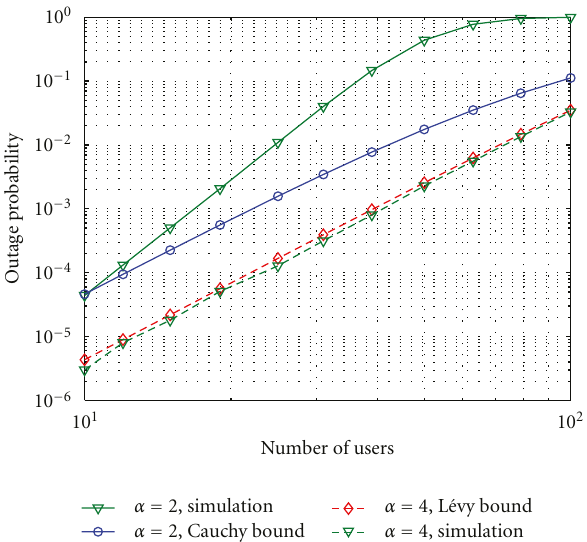
Figure 6: The outage probability P out versus the number of users N α = 2 for u in multipath channels, where and 4 are, respectively,